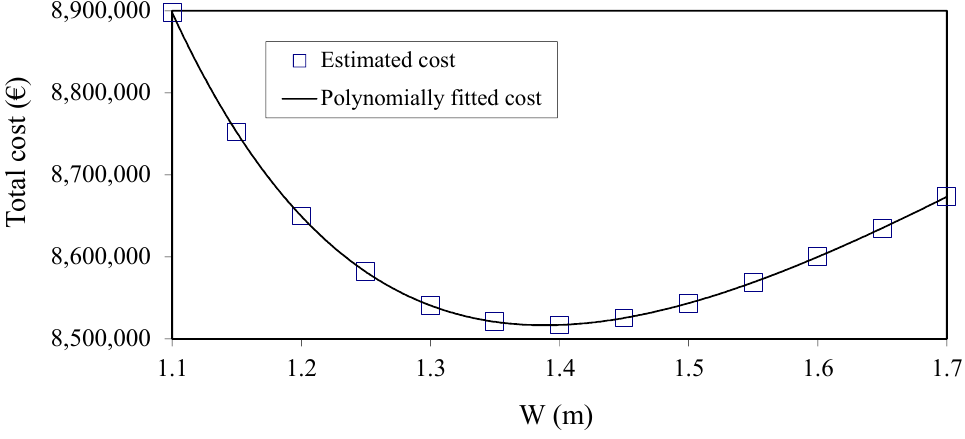
Figure 8. Total costs (€) as function of additional height of the crest element, W (m) for K D = 4.9.